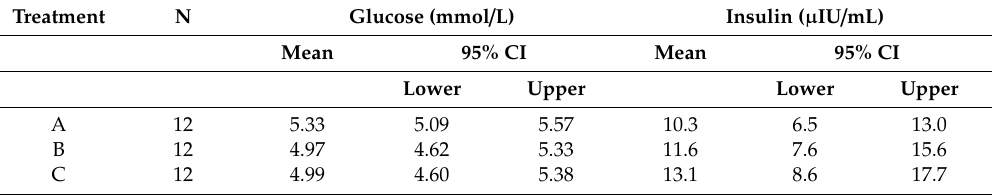
Table 1. Calculated mean blood glucose and insulin and insulin concentrations of all subjects at the start. ( t = 0 min) of each treatment